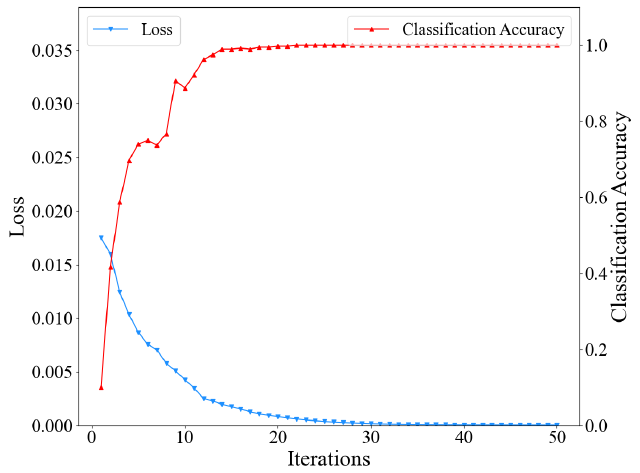
Figure 5. The loss and classification accuracy of proposed method on CWRU dataset.